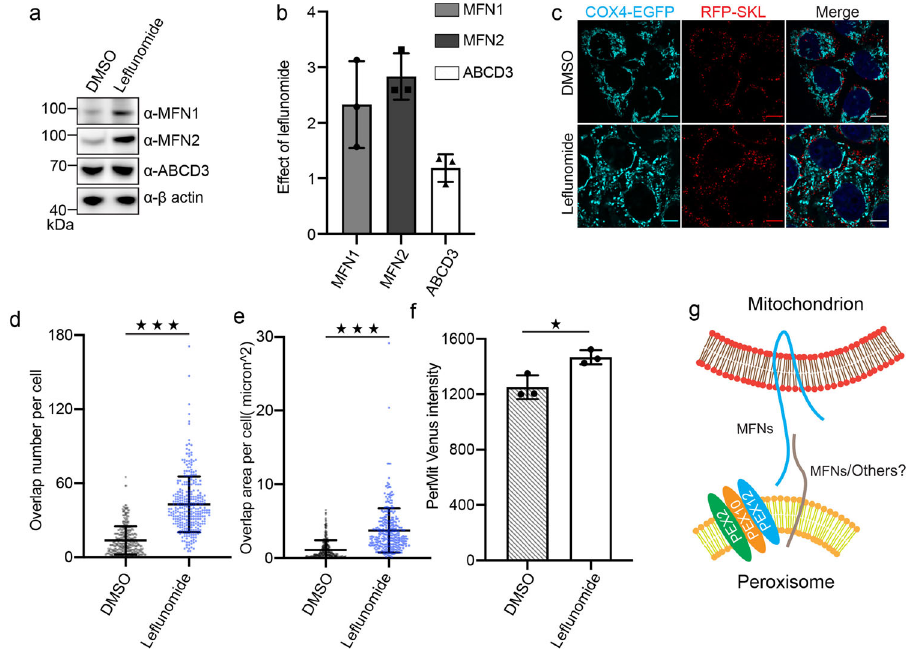
Fig. 7 Upregulation of endogenous mitofusins stimulates mitochondrion-peroxisome contacting. a Immuno-blots of MFN1, MFN2, and ABCD3 in cells treated with/without le fl unomide. b Fold change of protein levels on immune-blots ( a ), quanti fi ed with ImageJ ( n = 3, error bars represent standard deviation). c Representative fl uorescence images of the HeLa cells stably expressing COX4-EGFP and RFP-SKL, treated with either DMSO or le fl unomide (50 μ M, 48 h). d , e Quanti fi cation of peroxisome and mitochondrion overlap in images collected in ( c ). Scatter dot plots showing peroxisome and mitochondria overlap number and area in HeLa cells incubated with DMSO ( n = 348 cells) and 50 μ M le fl unomide ( n = 310 cells) respectively for 48 h. *** p < 0.001. Mean with SD. P values calculated via unpaired Student ’ s t-test (two-tailed). f The Venus fl uorescence intensity in cells treated with either DMSO or 50 μ M le fl unomide were analyzed with fl ow cytometry. At each condition, the mean fl uorescence intensity (MFI) is calculated from 20,000 to 60,000 cells. The experiment was repeated for three times. The columns represent average MFI (mean fl uorescence intensity) with SD. * p < 0.05, calculated via unpaired Student ’ s t-test (two-tailed). g A working model for MFN mediated PerMit